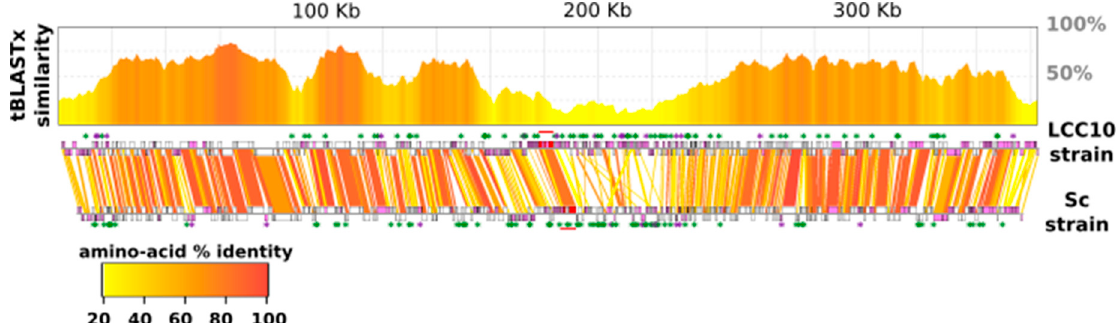
Figure 5. Genome conservation and colinearity between KV strains. Top panel: Levels of amino-acid similarity between the LCC10 and Sc genomes as measured by the tBLASTx program. The genomic coordinates refer to LCC10 strain. Bottom panel: gene collinearity between the LCC10 (top) and Sc (below) genomes. Open and purple-filled boxes represent single copy genes and genes engaged in a multi-gene family, respectively. Green asterisks indicate genes that are unique to the considered KV strain (i.e., without a BLASTP match with e-value < 1 × 10 − 5 against the other KV strain), whereas purple asterisks show strain specific genes that are also engaged in a multi-gene family. Colored links associate the putative LCC10 and Sc orthologous genes identified by the reciprocal best BLAST hit criterion. The coloring of the links represents the level of amino-acid similarity between orthologous proteins according to the color scale given. The horizontal red lines mark the position of the MCP genes.